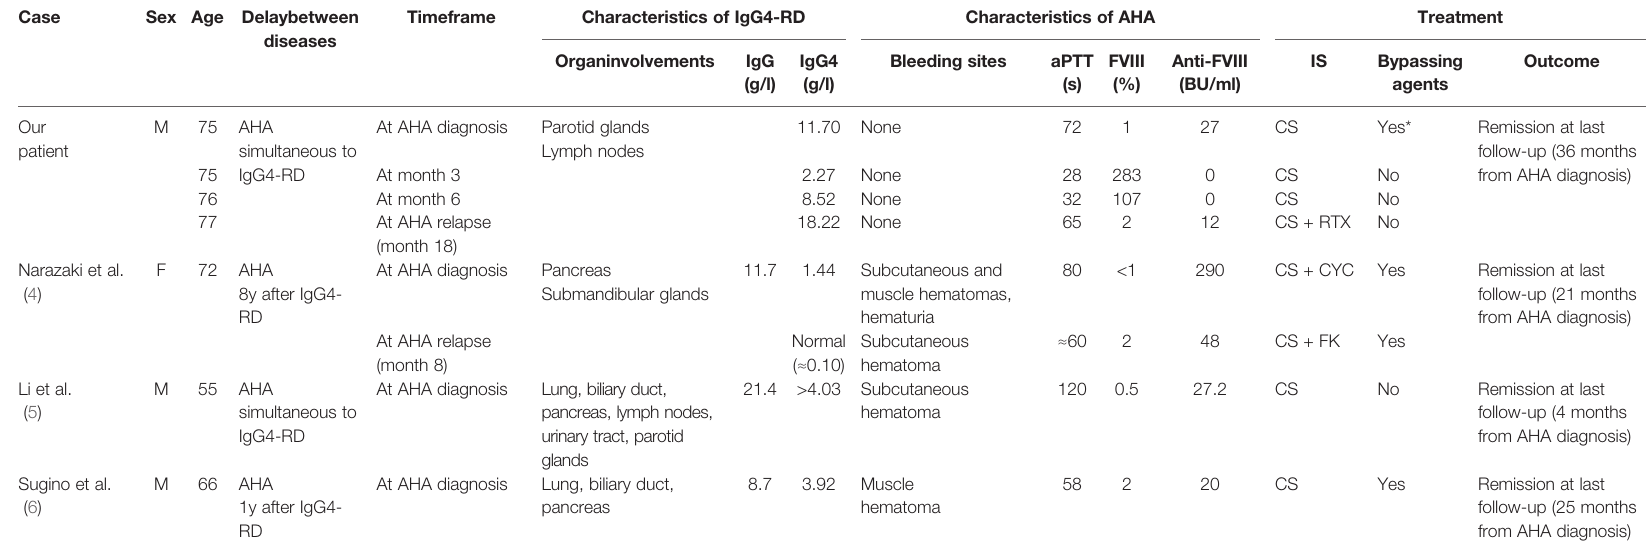
TABLE 1 | Clinical and biological data of our patient and other IgG4-RD-associated AHA